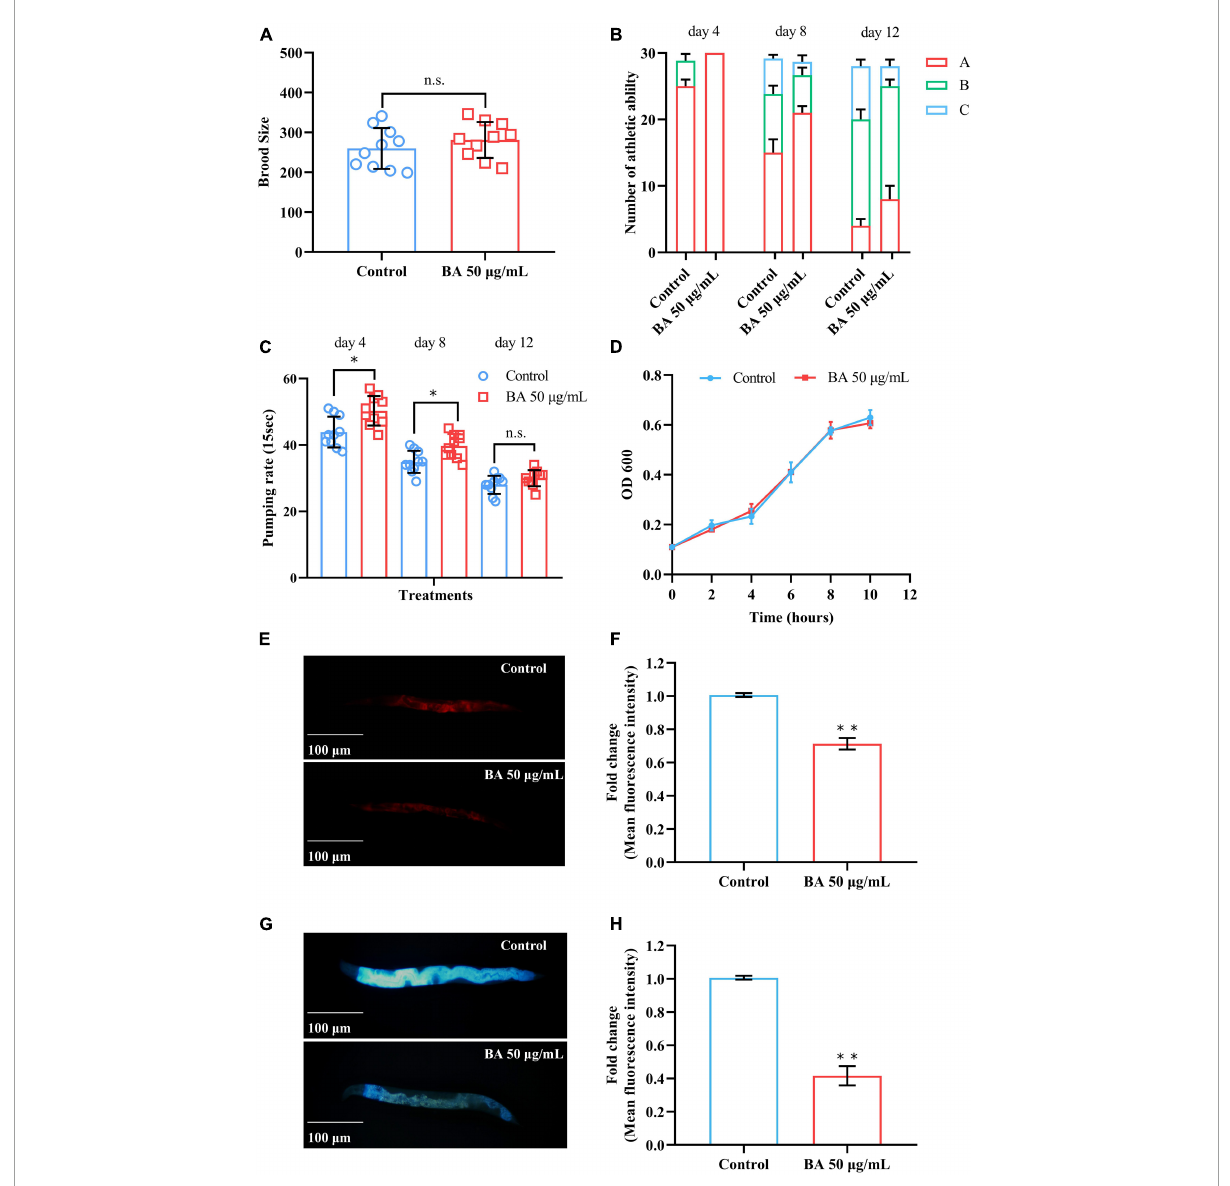
FIGURE2 Betulinic acid (BA) delays age-associated physiological decline. (A) Reproductive capacity of Caenorhabditis elegans supplied. (B) Age-dependent motor activity of C. elegans . (C) Pharyngeal pumping rates of C. elegans . (D) Growth rate of Escherichia coli OP50 under 50 µ g/mL BA treatment. (E–H) Lipofuscin induced auto-fluorescence under 550/605 nm (Ex/Em) and 355/445 nm (Ex/Em) detection. Data were displayed as mean ± SEM. For panel (C) , comparisons represent the One-way ANOVA followed by post-hoc Bonferroni’s test. For panels (A,F,H) , comparisons represent two-tailed unpaired Student’s t- test. ∗ P < 0.05; ∗∗ P < 0.01; ns =